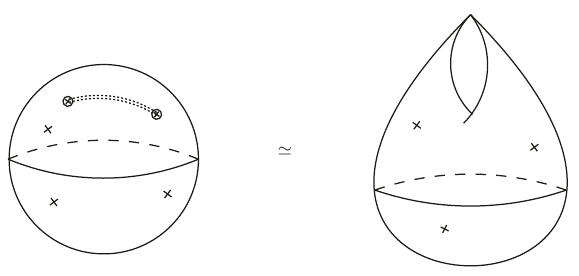
Figure 2 . The gluing operator identifies two points in a genus zero correlator, forming a nodal